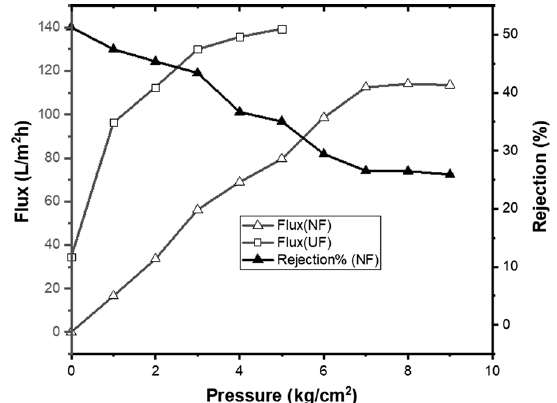
Fig. 8 Effect of operating pressure on flux and % TDS rejection of NF membrane and UF flux